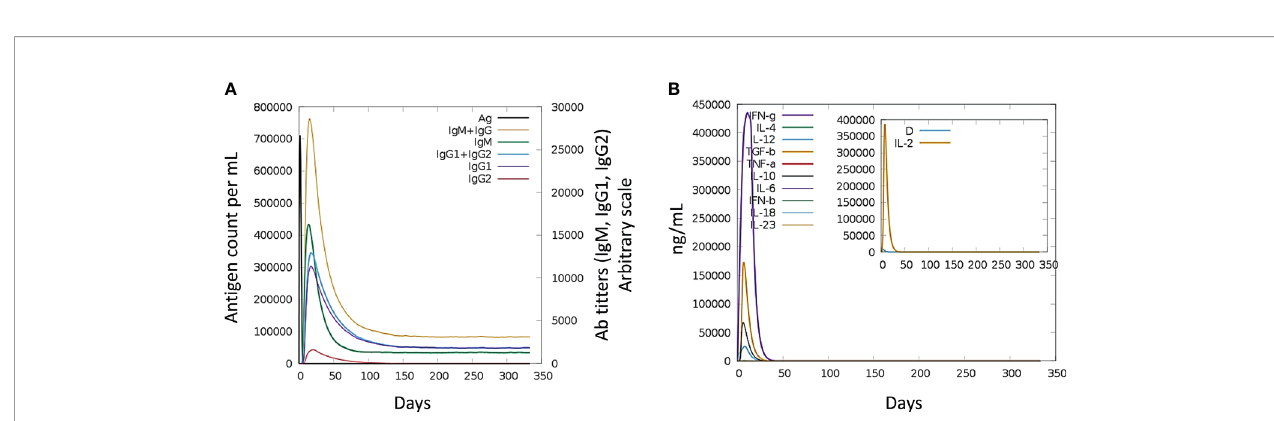
FIGURE 5 | Host immune system simulation in response to. The immune response (generation of Igs) by antigen exposure are shown in (A) , and cytokines and interleukins production in different stated with Simpson index is shown in (B)